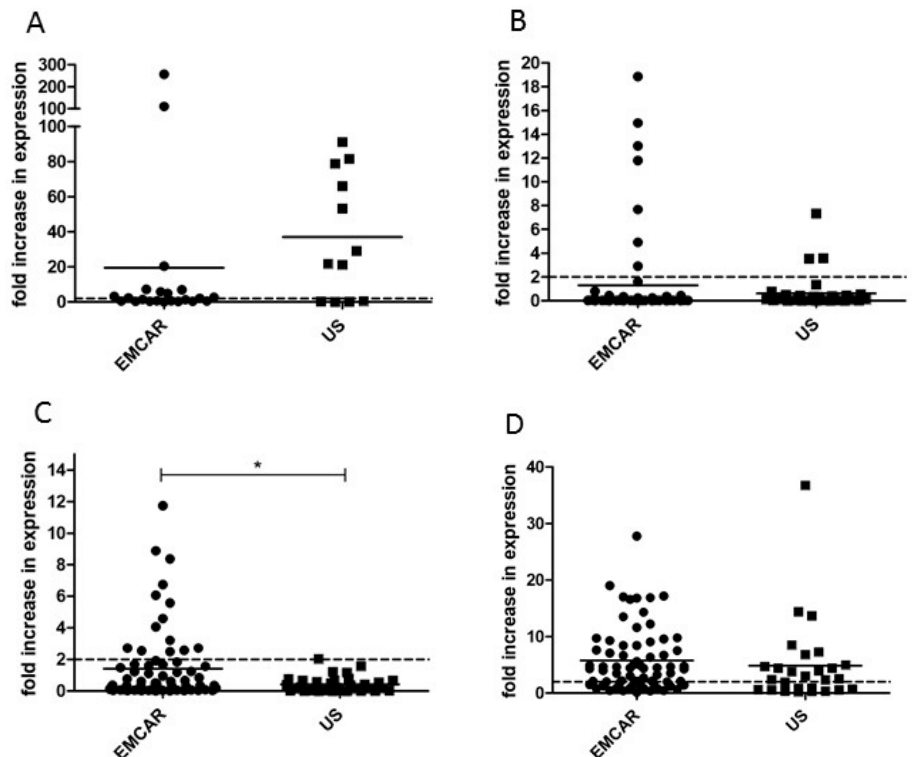
Figure 1. mRNA expression of TAA in uterine tumors: ( A ) BORIS expression; ( B ) MAGE-A3 ; ( C ) Sp17 ; and ( D ) hTERT . Results are expressed as fold change compared to the mean normalized expression of normal endometrium. Overexpression is defined as two-fold increase compared to normal endometrium (dashed line). TAA: tumor-associated antigen; EMCAR: endometrial carcinoma; US: uterine sarcoma; BORIS: brother of the regulator of imprinted sites; MAGE-A3: melanoma-associated antigen A3; Sp17: sperm protein 17; hTERT: human telomerase reverse transcriptase; * p < 0.05.